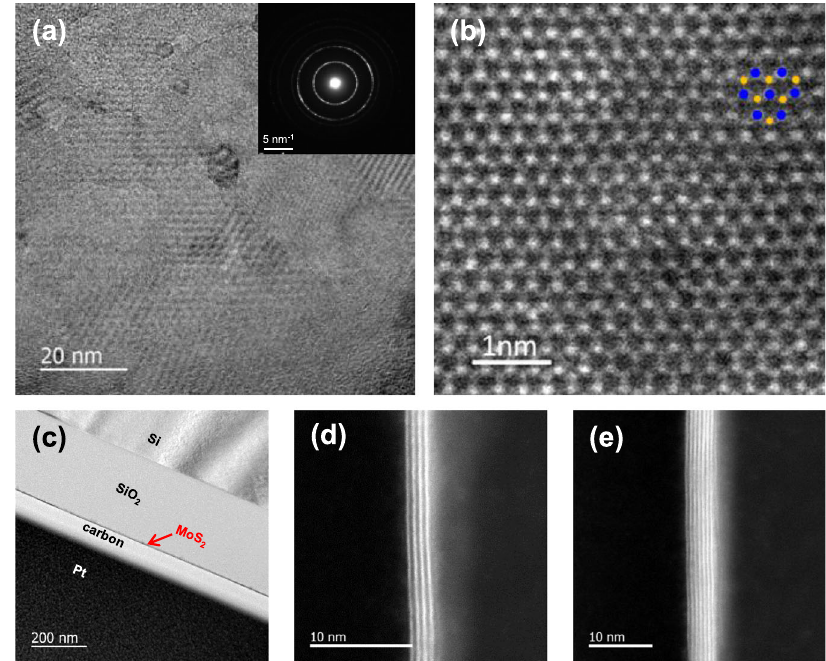
Fig. 4 TEM analyses of MoS 2 atomic fi lms. a ADF-STEM plan view with corresponding SAED pattern; b high-resolution dark- fi eld STEM plan view of 0.0125 M MoS 2 ; Mo and S atoms are marked as blue and orange colors, respectively. c Low-resolution and d high-resolution STEM cross-sectional view of 0.0125 M of MoS 2 and e high-resolution STEM cross-sectional view of 0.025 M of MoS 2 .